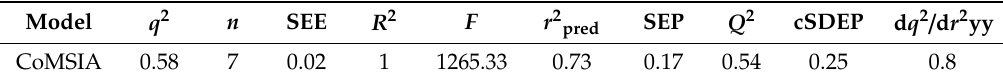
Table 2. Evaluation parameters of the CoMSIA model based on the characterization values of double-activity quinolones’ green algae and bacterial genotoxicity.